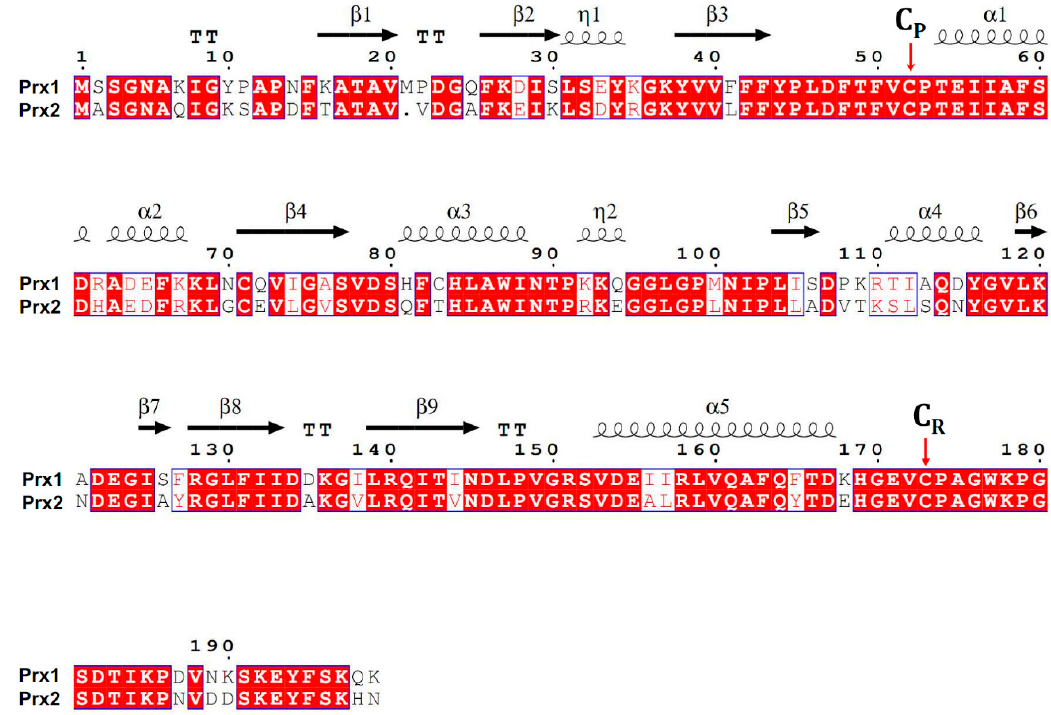
Figure 1. Alignment of amino acid sequences of mouse Prx1 and Prx2 (ClustalOmega, ESPript 3.x). The peroxidatic (C P ) and resolving cysteine (C R ) residues indicated by an arrow (Cys52 and Cys173 for Prx1, Cys51 and Cys172 for Prx2). The secondary structure of conserved regions ( α -helices, β -strands) is shown above the amino acid sequence of Prx1.